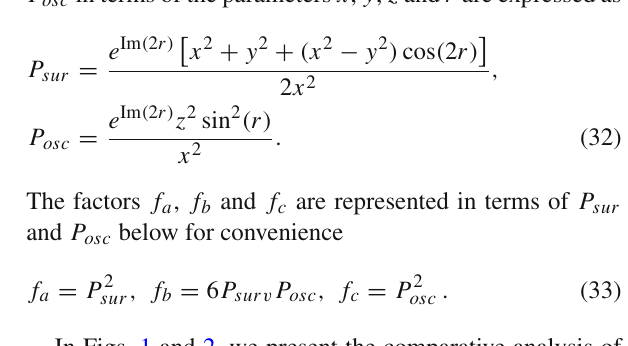
km, E ≈ 1 − 8 MeV; f lower right: Daya Bay, L = 2 km, E ≈ 0 . 8 − 6 MeV. The solid (green) line corresponds to oscillation in vacuum, the dashed (blue) and dot-dashed (red) lines represent the results for SM and NSI, respectively. Dotted (black) line represents the classical bound of M( ρ